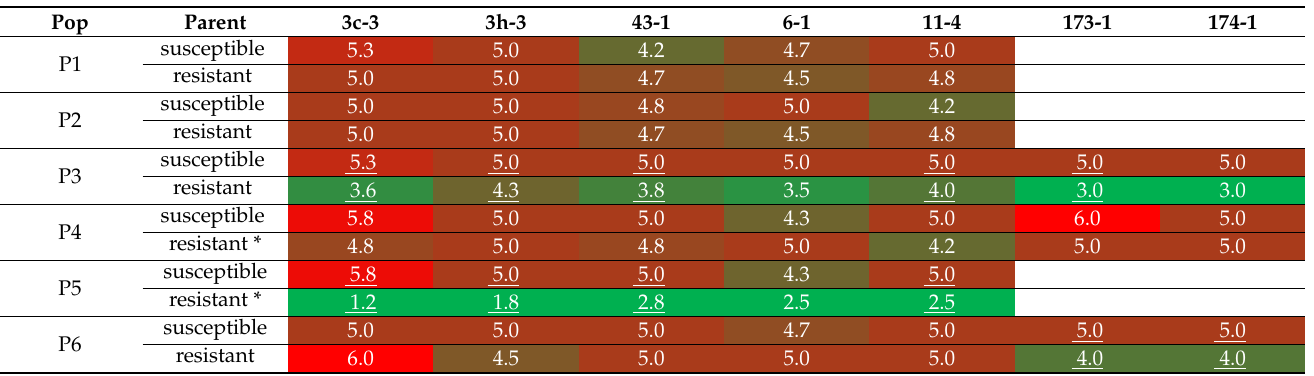
Table 5. Results of parental lines tested in the seedling stage with different stem rust isolates